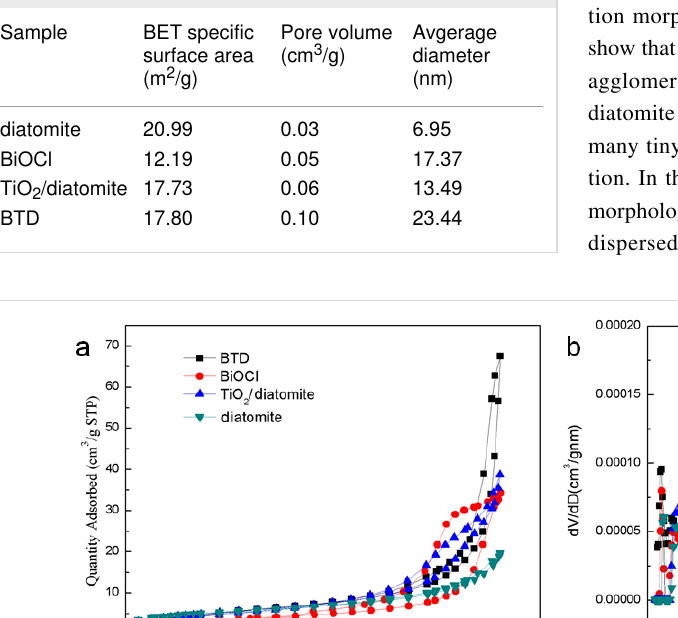
Table 1: Specific surface area and pore volume of BiOCl, diatomite, TiO 2 /diatomite and